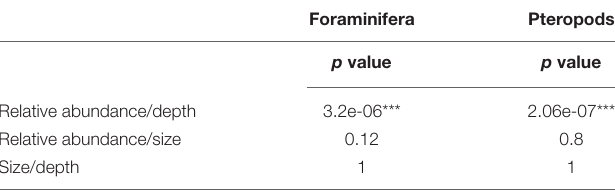
TABLE 3 | Results of the two-way ANOVA test.